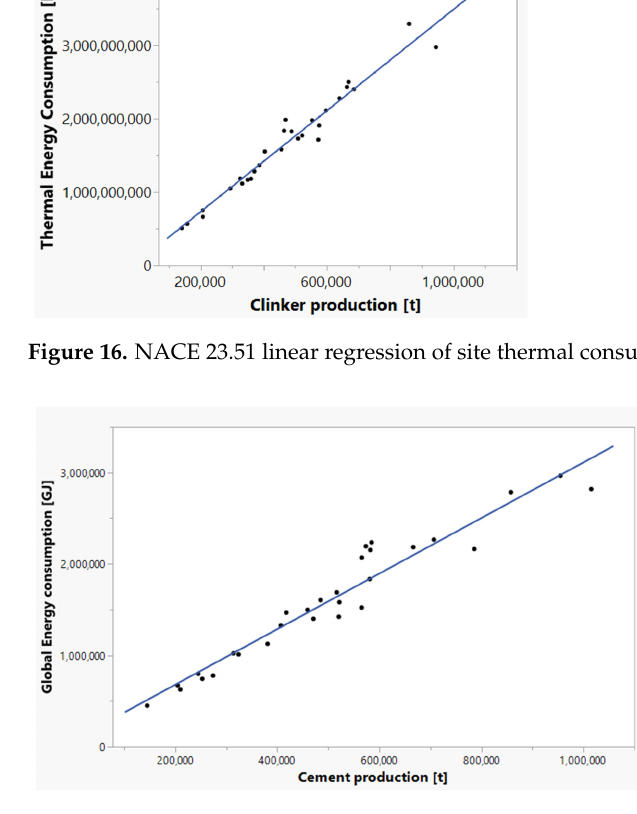
Figure 17. NACE 23.51 linear regression of site global energy consumption. Table 2. NACE 23.51: statistical parameters of linear regression of electric, thermal, and global site consumptions. Energy